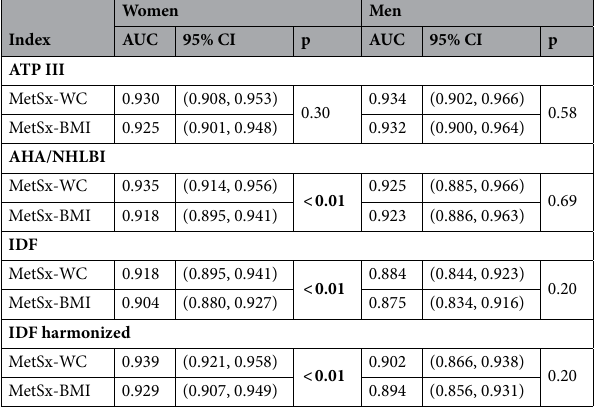
Table 8. AUC of MetSx for the binary diagnosis of MetS. AUC area under the ROC curve, CI confidence interval. Significant p-values are in